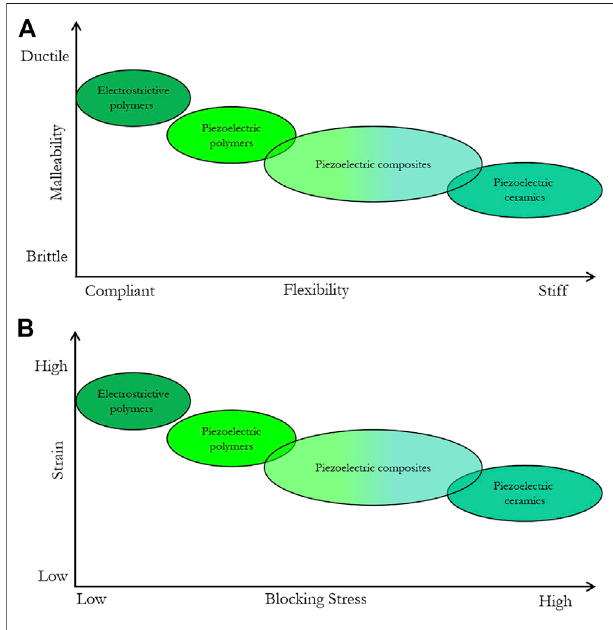
FIGURE 5 | Schematic representation of the mechanical (A) and electromechanical (B) properties of fl exible electroactive materials.